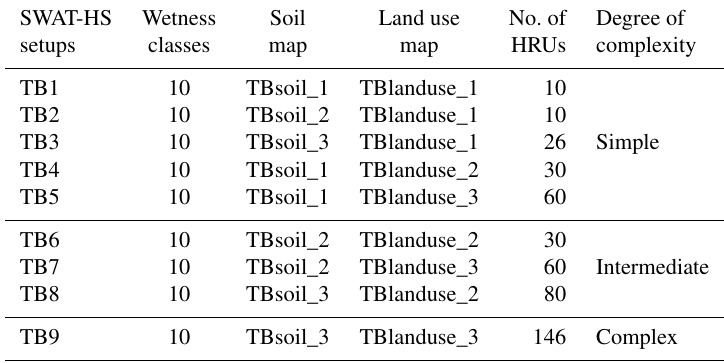
Table 2. SWAT-HS model setups with increasing levels of complexity.